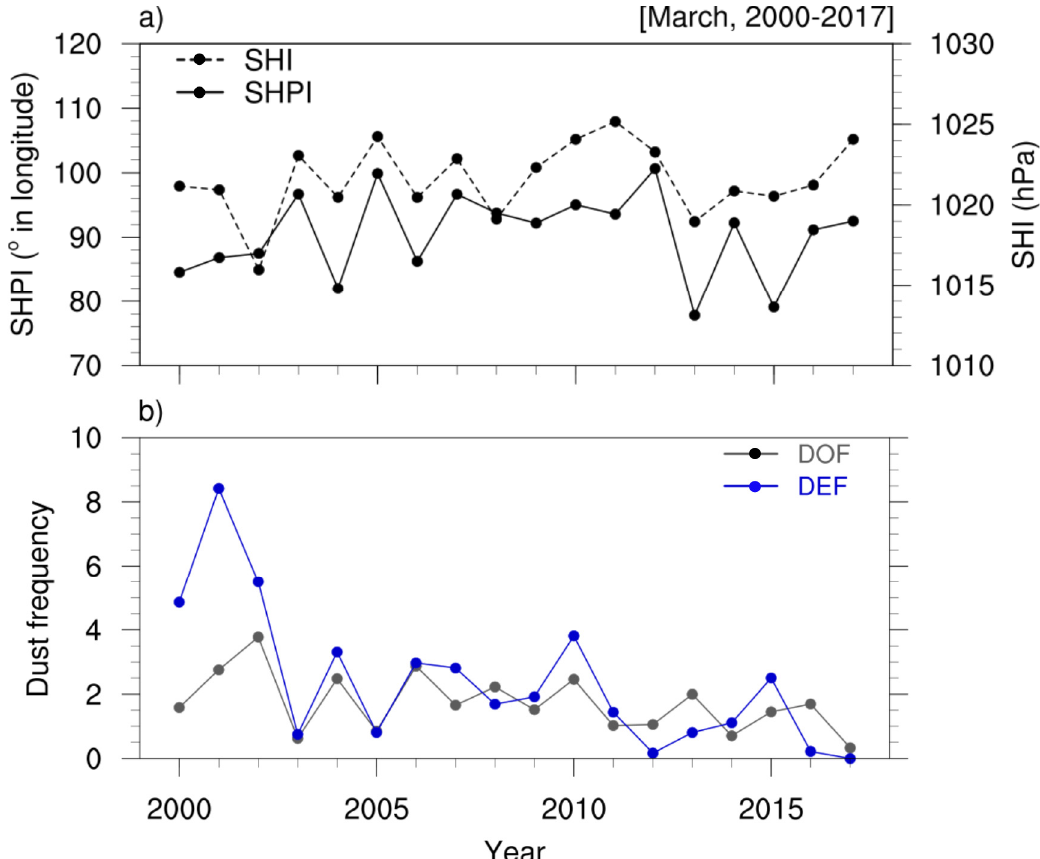
Figure 3. Time series of ( a ) the SHI (black dashed line with the closed circle; hPa) and SHPI (black solid line with the closed circle; ° in longitude) and ( b ) DOF (grey line with the closed circle) and DEF (blue line with the closed circle) in March, 2000–2017. Pearson’s correlation coefficient ( r ) between indices are the following: r (SHI, SHPI) = +0.62 ( p < 0.05), r (SHI, DEF) = − 0.38, r (SHPI, DEF) = − 0.36, r (SHI, DOF) = − 0.70, r (SHPI, DOF) = − 0.44. Shaded orange and blue bands denote the three years used for the Strong–East and Weak–West composites, respectively. Dark red and blue colors indicate the Strong-SHI and Weak-SHI from the SHI-only group, whereas light red and blue colors indicate for the East-SHPI and West-SHPI from the SHPI-only group. See also in Tables S1 and S2.